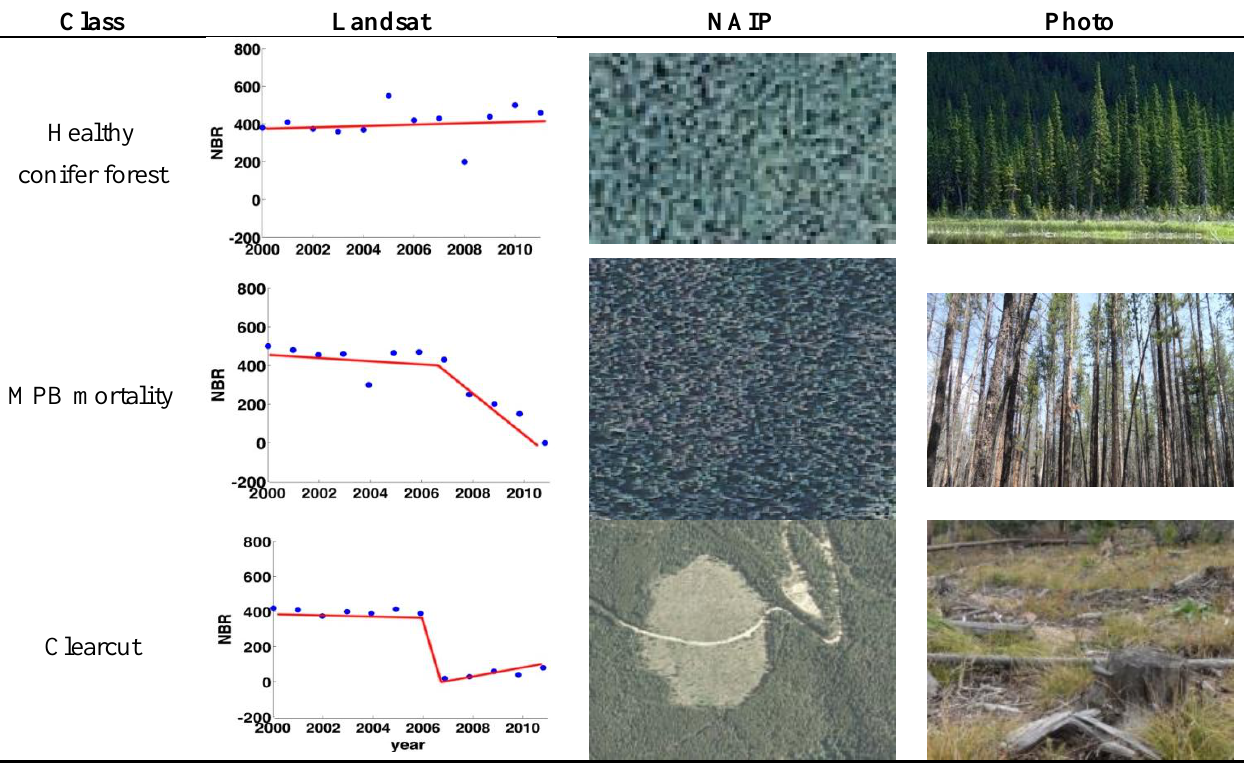
Table 2. Examples of normalized burn ratio (NBR) trajectories, National Agricultural Imagery Program (NAIP) data and in situ photos for healthy forest, MPB mortality and clearcut